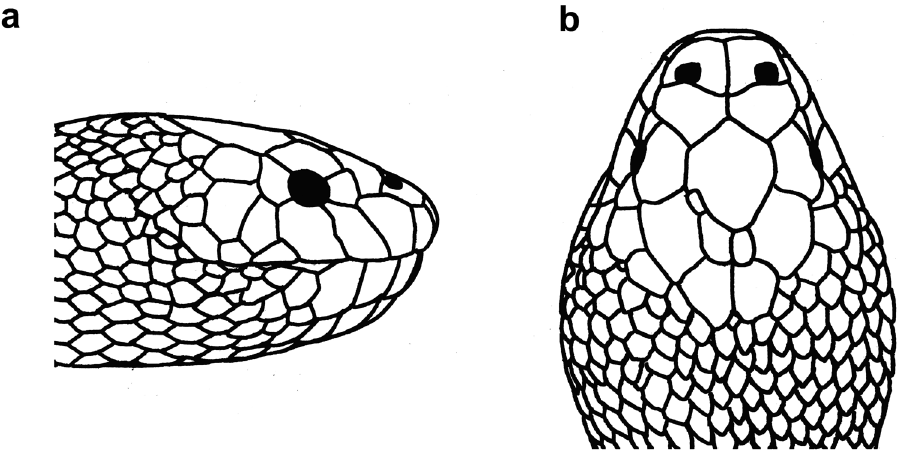
Figure 10. Head of Hydrophis curtus : a lateral view b dorsal view.